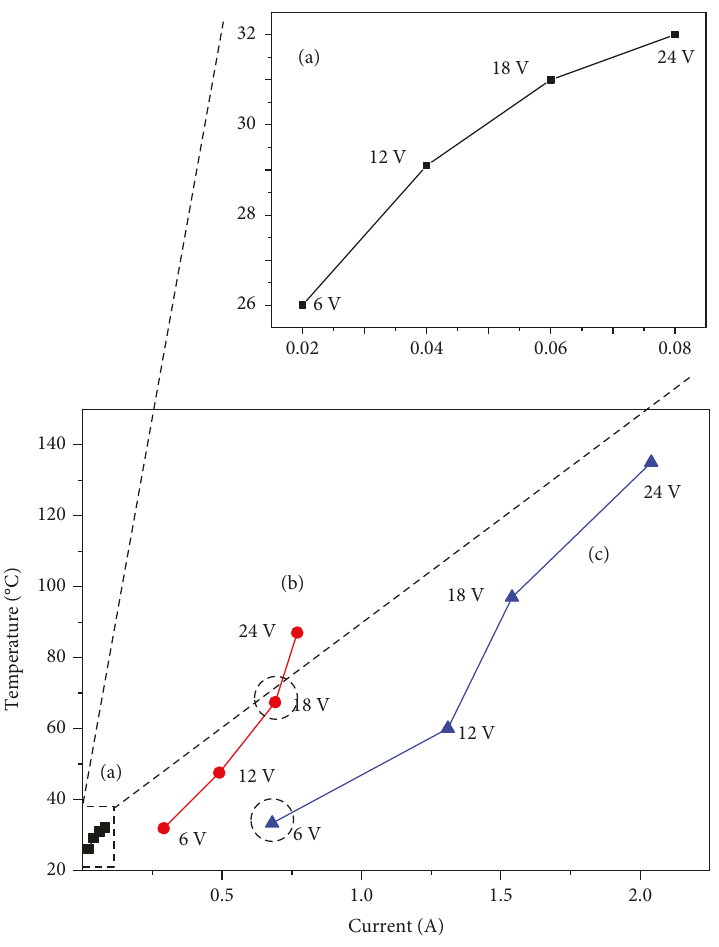
Figure 6: Heating temperature measured on the heating fi lm under application of DC power; (a) PMMAGr-30, (b) PMMAGr-40, and (c) PMMAGr-50. The numbers -30, -40, and -50 indicate the graphite amount (wt.%) added to the composite fi lms of 100 μ m